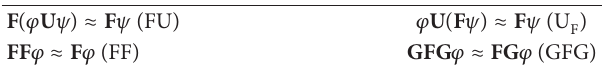
Table 3: Reduction rules for formulae involving nested pure future